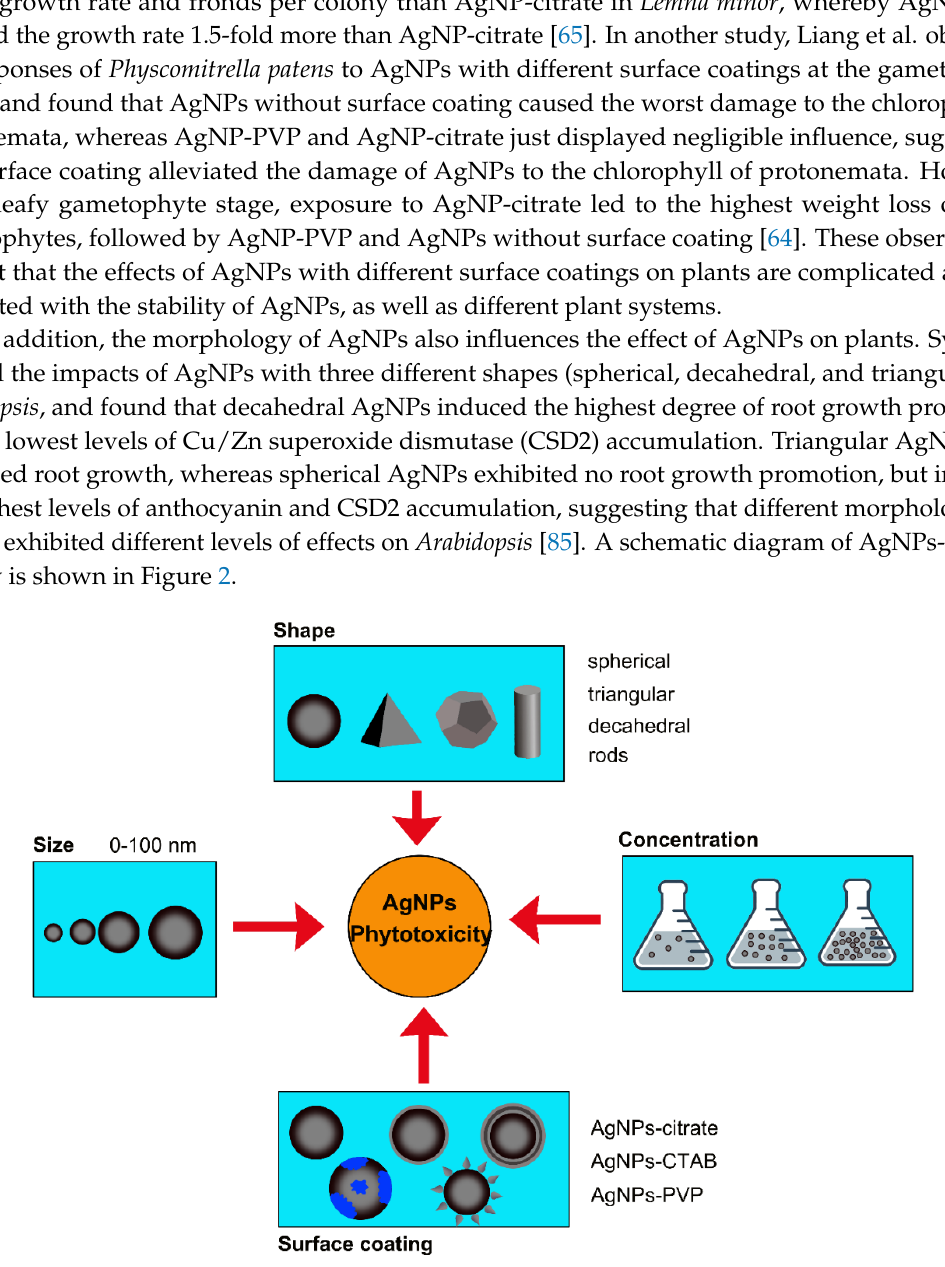
Figure 2. Schematic diagram showing AgNP-specific toxicity. The phytotoxicity of AgNPs is determined by AgNP properties, including size, shape, concentration, and surface coating of AgNPs.